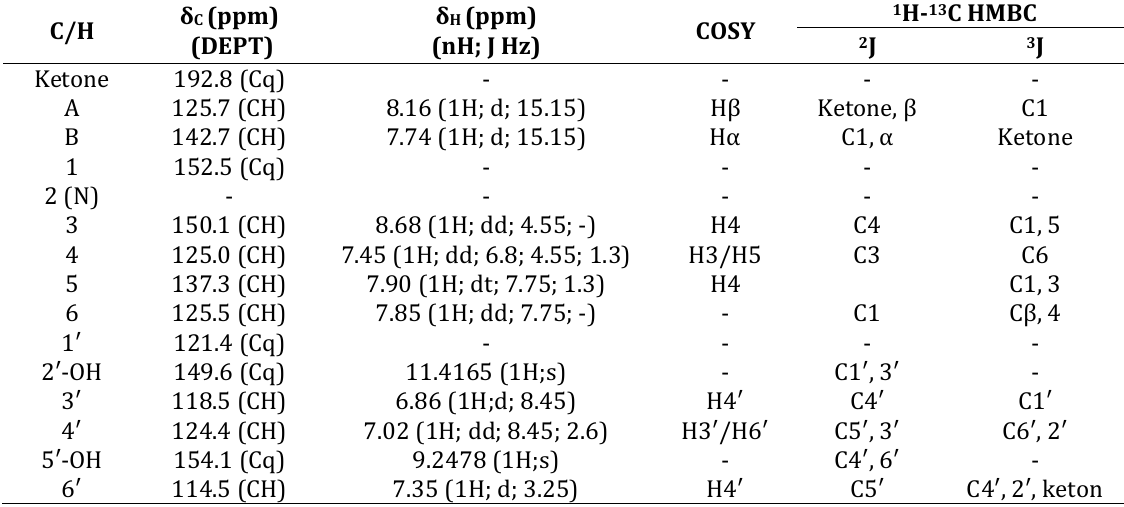
Table I. Spectra H NMR , 13 NMR, DEPT, COSY, HMBC C/H